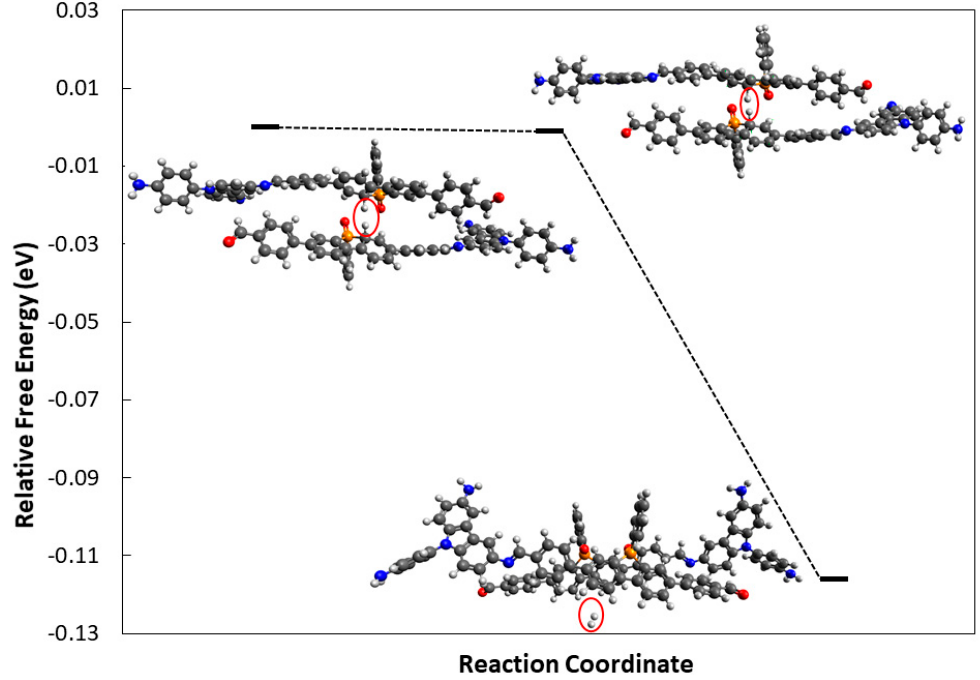
Figure 8. Energy diagram of intermolecular H 2 formation using two protonated PCzPO D-A moiety models, computed by DFT.